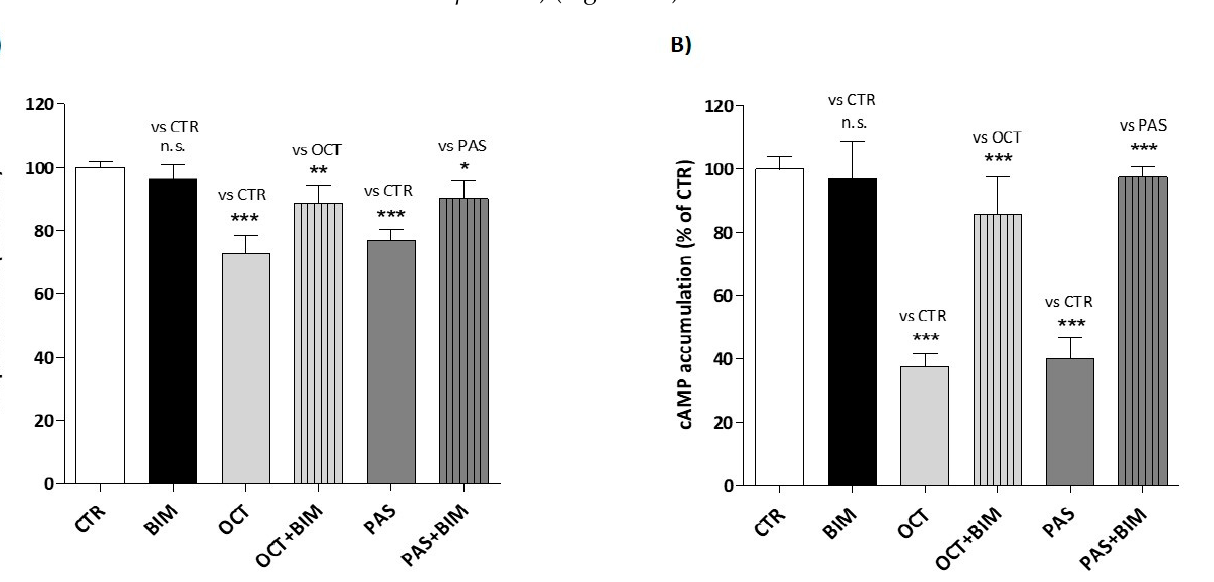
Figure 5. Effect of the SST 2 -selective antagonist (BIM-23627) on SRL-induced inhibition of cell proliferation and cAMP accumulation in GH4C1 cells. Effect of OCT (10 − 8 M), PAS (10 − 8 M) and BIM-23627 (10 − 8 M), alone or in combination, on GH4C1 cell proliferation ( A ) and intracellular cAMP levels ( B ). Data are expressed as mean percent inhibition of untreated cells ± SEM of four different experiments ( A ) and three different experiments ( B ) performed in triplicate. (CTR, control; OCT, octreotide; PAS, pasireotide; BIM, SST 2 -selective antagonist; n.s., not statistically significant; * p < 0.05, ** p < 0.01, *** p < 0.001 vs. control).